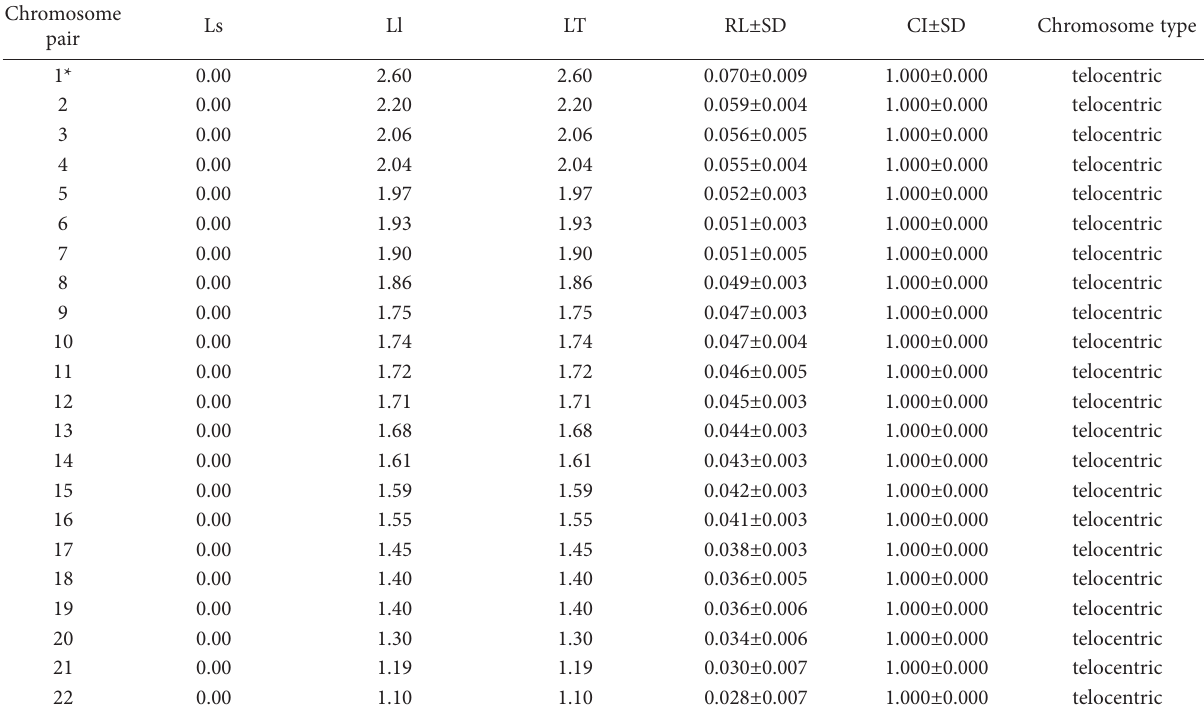
Table 2. Mean length of short arm chromosome (Ls), length long arm chromosome (Ll), length total arm chromosome (LT), relative length (RL), centromeric index (CI) and standard deviation (SD) of RL, CI from 20 metaphase cells of the male and female the Picasso triggerfish ( Rhinecanthus aculeatus ), 2 n